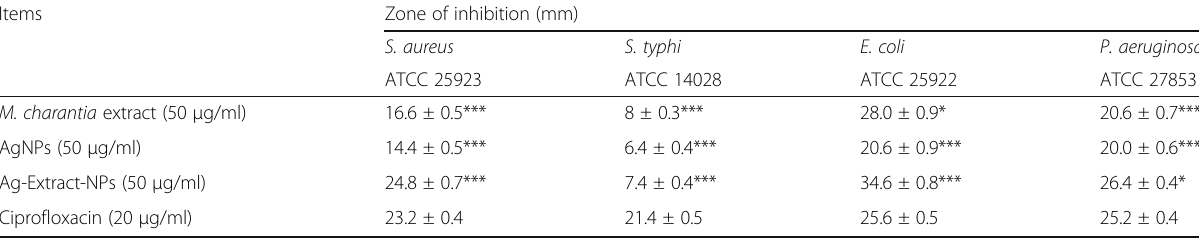
Table 2 Antibacterial activity of M. charantia extract, AgNPs and Ag-Extract-NPs